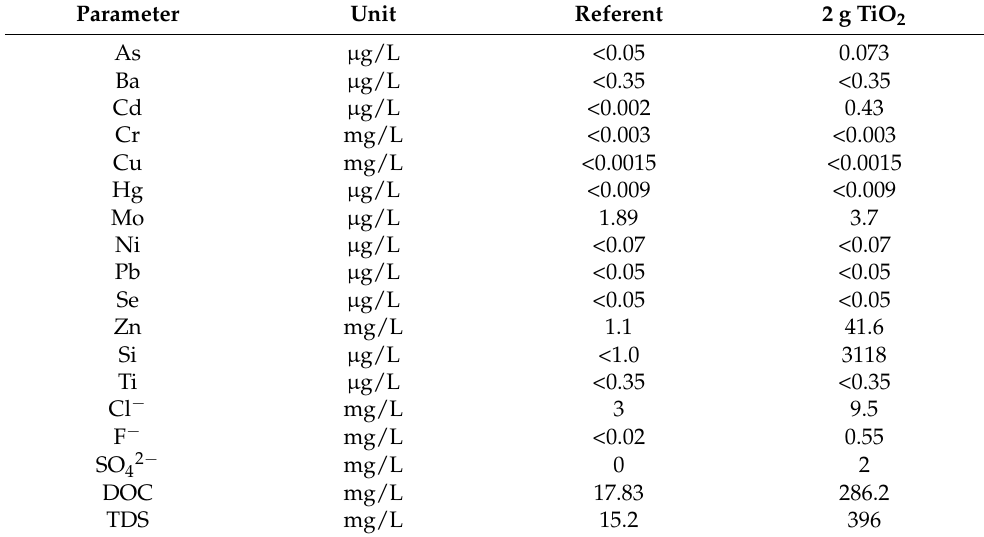
Table 4. Results of leaching test for red rubber.